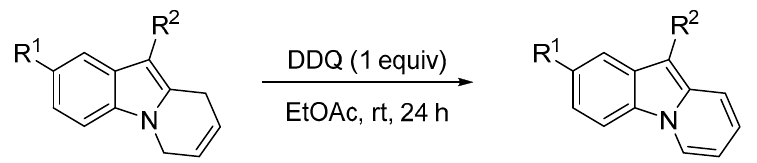
Scheme 27. DDQ-mediated aromatization of dihydropyridoindoles.